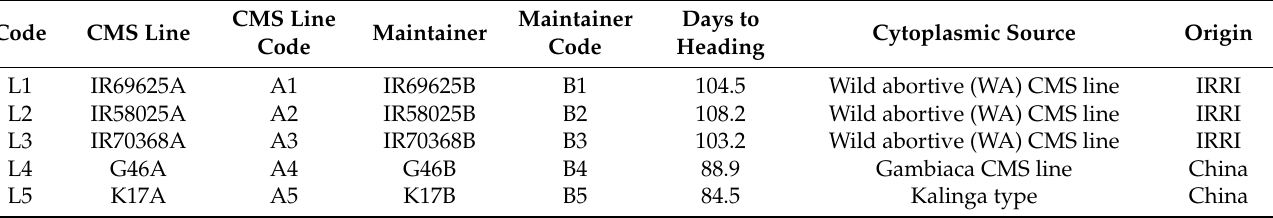
Table 4. Cytoplasmic male sterile (CMS) lines used for the